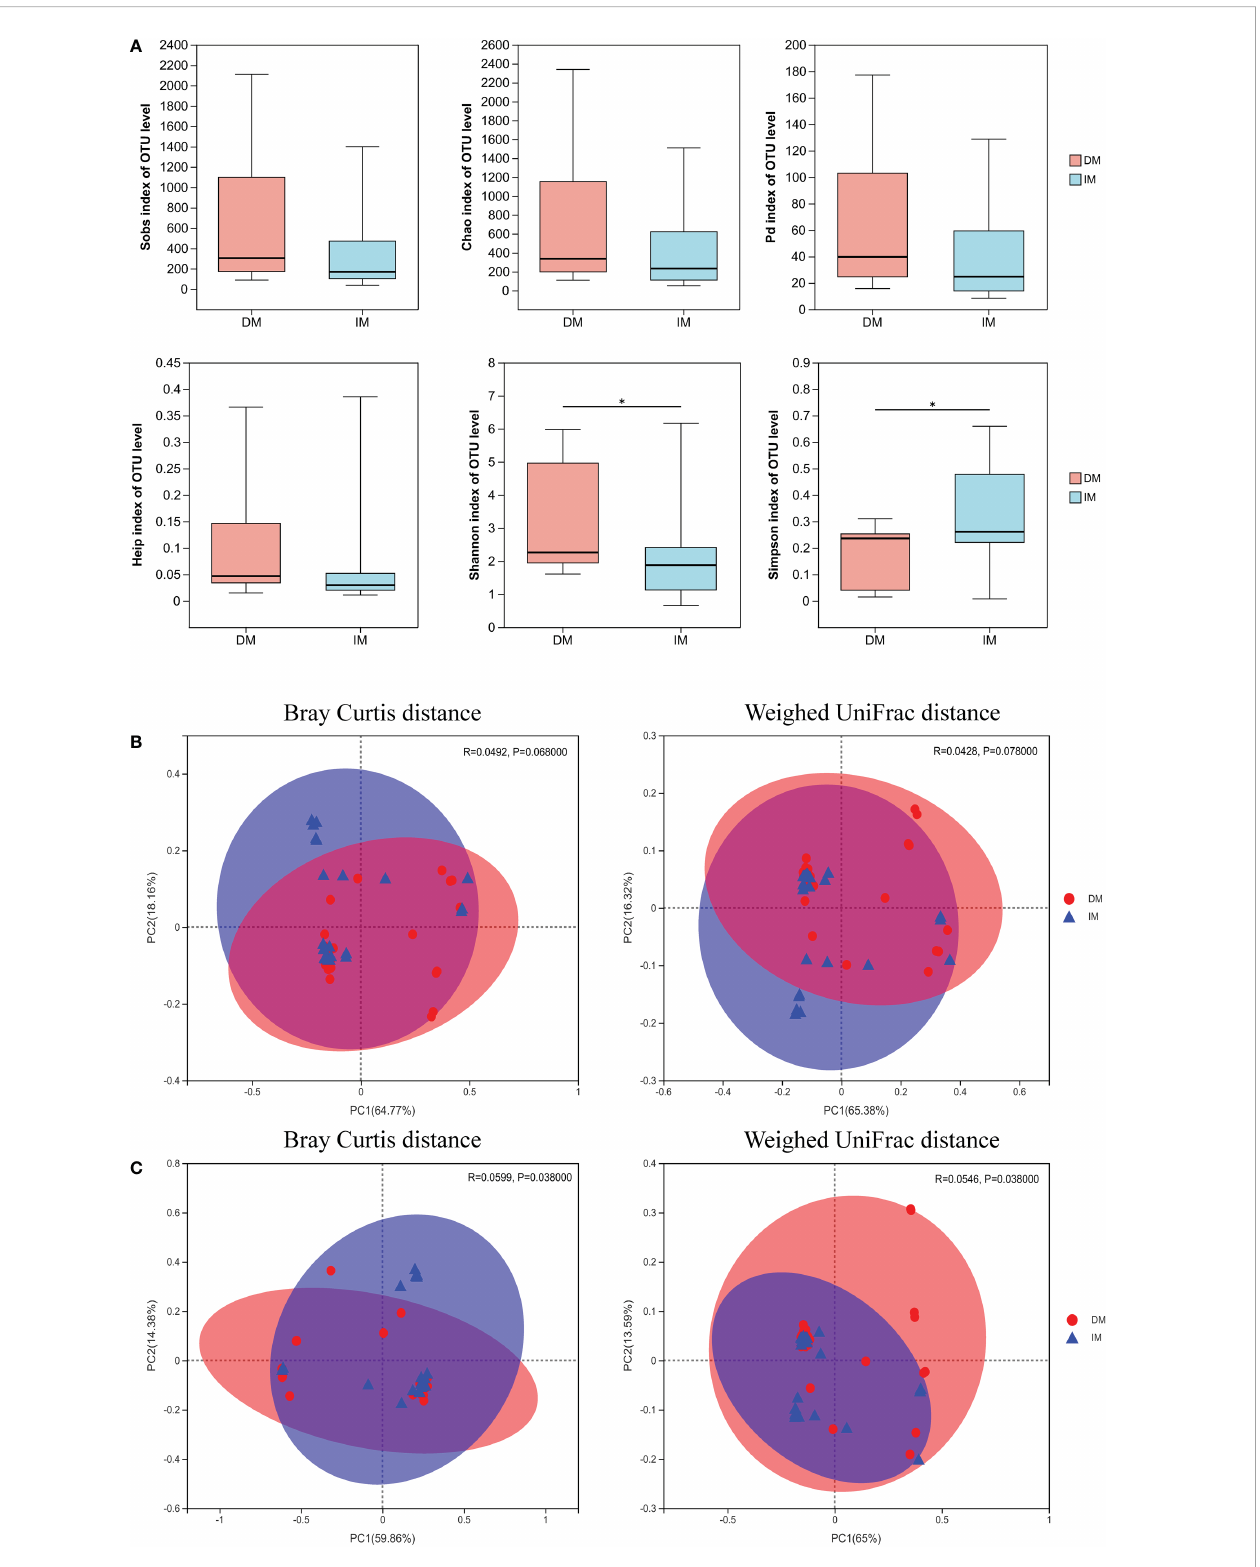
FIGURE 3 Tumor microbial alpha- and beta-diversity analysis based on in fl uencing factors in both groups. (A) Microbial alpha diversity boxplot (observed OTUs, Sobs, Chao1, Pd, Heip, Shannon and Simpson indices) in SCRC patients. The DM (red) and IM (blue) groups (on the x-axis) and the different index types (on the y-axis). The PCOA plots of Bray Curtis and weighted UniFrac metric distances of beta diversity, (B) at the phylum level and (C) at the genus level. In the panel, each point represents a single DM (red circle) or IM (blue triangle), with ellipses (red ellipses= DM, blue ellipses = IM) representing the fi tted mean and 95% con fi dence interval of each group, respectively. *p <